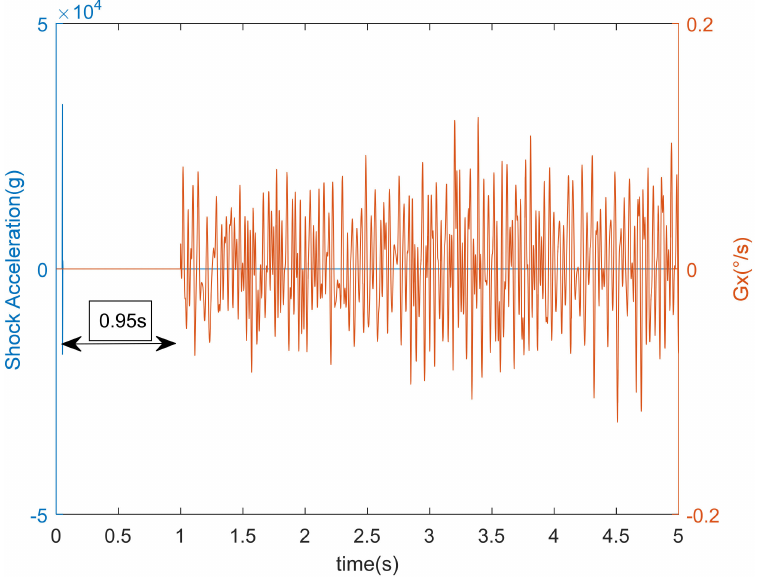
Figure 8. Delay time between recording and impact detecting. Table 2. Comparison of the micro inertial measurement unit (MIMU)’s performance before and after the